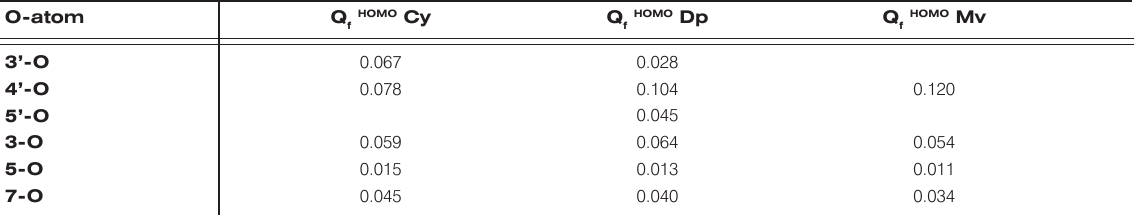
HOMO Cy Q HOMO f f